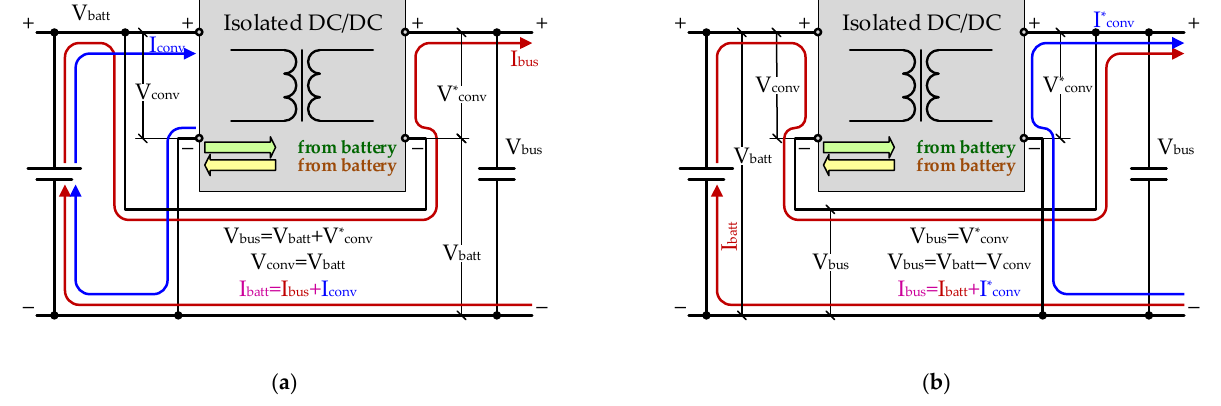
Figure 21. Structures of partial power converters: ( a ) parallel input—series output, ( b ) parallel output—series input.